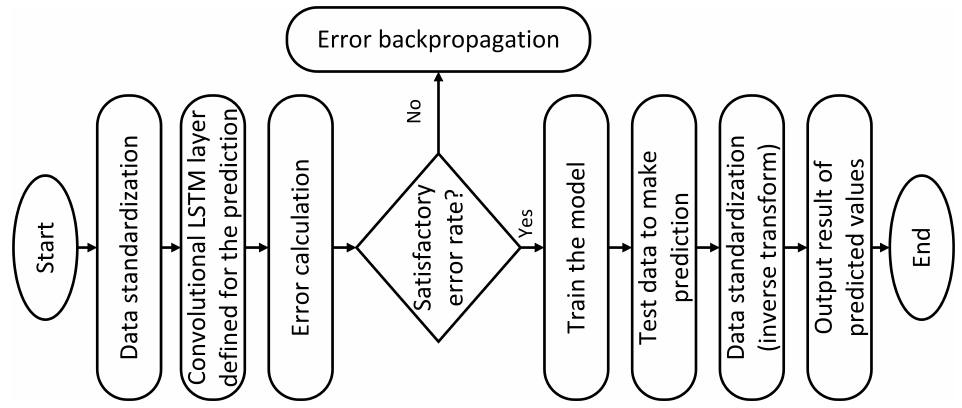
Figure 1. Activity diagram of a CNN-LSTM-based prediction